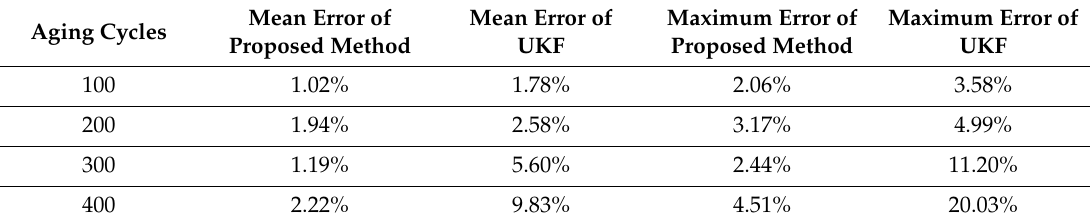
Table 5. Comparison of the SOC estimation errors in aging process.